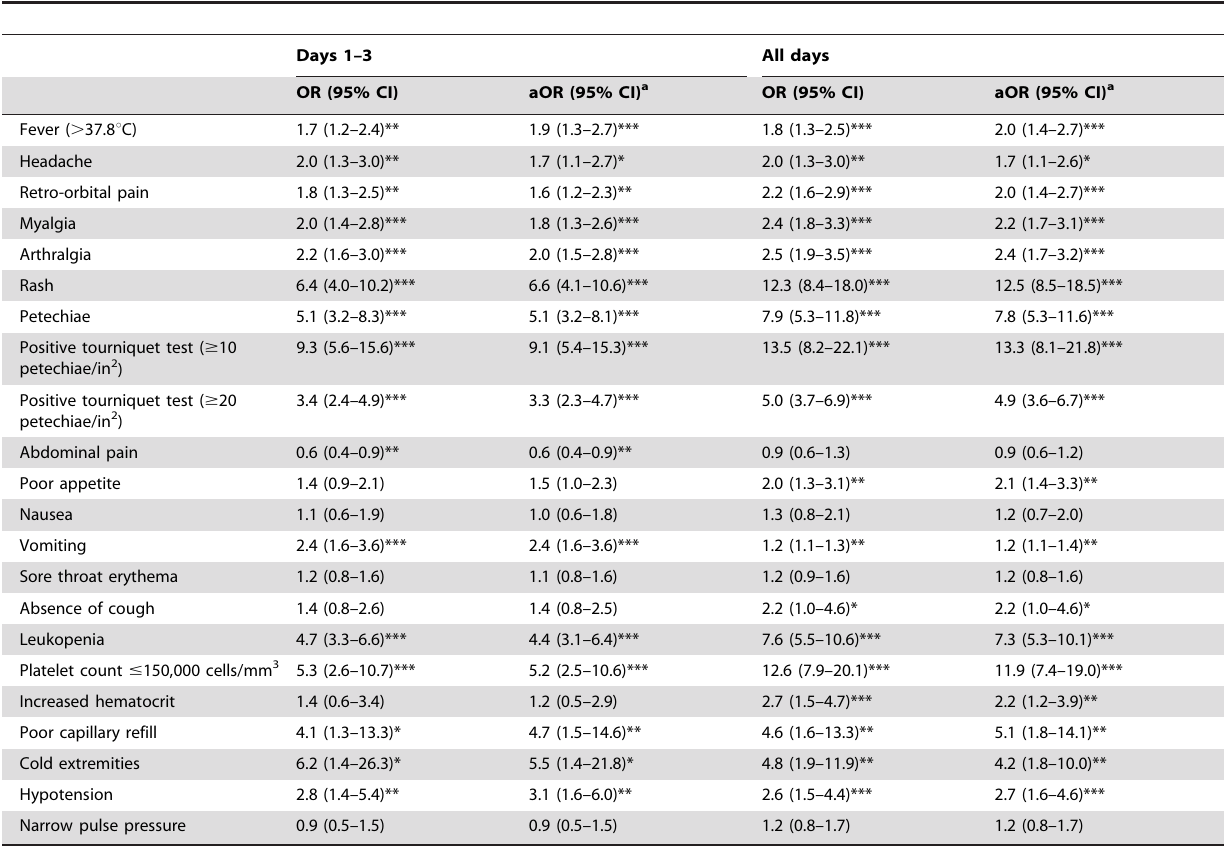
Table 3. Signs and symptoms associated with testing DENV-positive among patients using generalized estimating equation